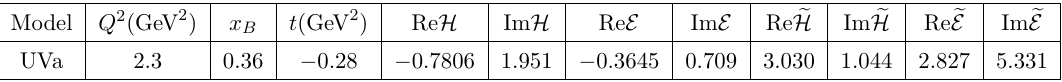
Table 4. Proton CFF values used for generating pseudo-data using Reggeized diquark GPD model [63,